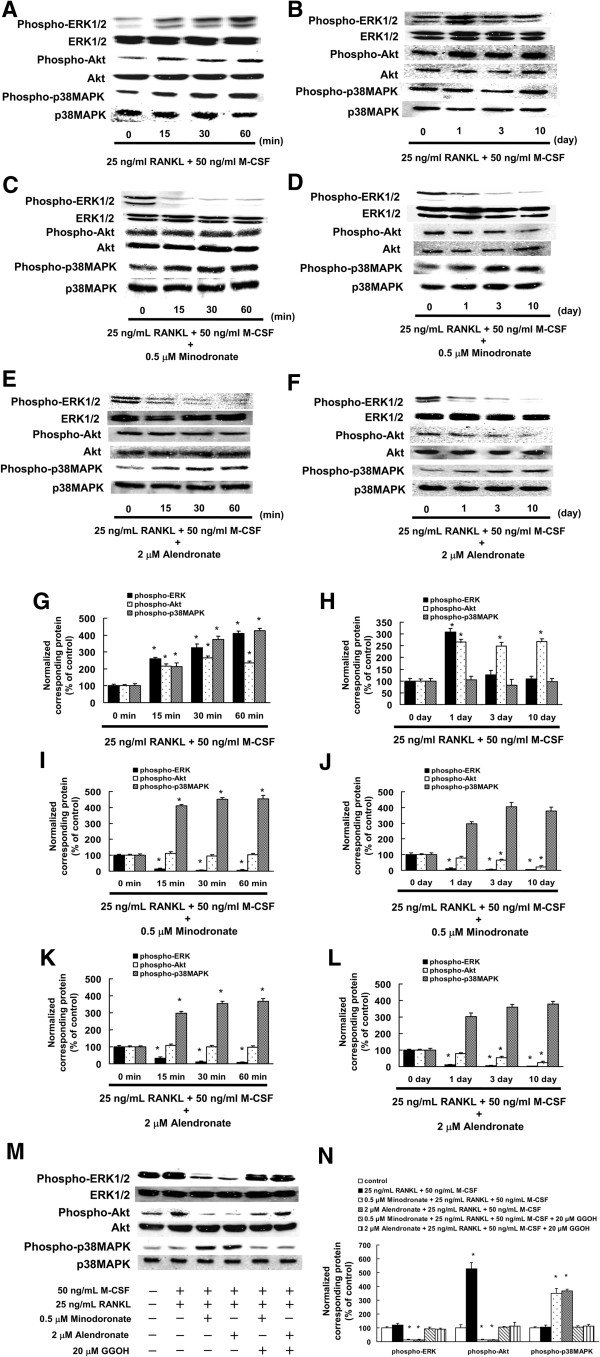
RANKL plus M-CSF induced activation of ERK1/2 and Akt in C7 cells, which could be inhibited by minodronate and alendronate. (A, B) C7 cells were cultured in the presence of 25 ng/mL RANKL plus 50 ng/mL M-CSF for 15, 30, and 60 min (A) or 1, 3, and 10 days (B). (C, D) C7 cells were treated with 0.5 μM minodronate for 24 h. Cells were cultured in the presence of 25 ng/mL RANKL plus 50 ng/mL M-CSF for 15, 30, and 60 min (C) or 1, 3, and 10 days (D). (E, F) C7 cells were treated with 2 μM alendronate for 24 h. Cells were cultured in the presence of 25 ng/mL RANKL plus 50 ng/mL M-CSF for 15, 30, and 60 min (E) or 1, 3, and 10 days (F). Whole cell lysates were generated and immunoblotted with an antibody against phosphorylated ERK1/2 (phospho-ERK1/2), phosphorylated Akt (phospho-Akt), phosphorylated p38MAPK (phospho-p38MAPK), ERK1/2, Akt, and p38MAPK. (G–L) Quantification of the amount of phospho-ERK1/2, phospho-Akt, or phospho-p38MAPK normalized to the amount of total ERK1/2, Akt, or p38MAPK, respectively. The results are representative of 5 independent experiments. *P < 0.01 compared to controls. (M) ERK1/2, Akt, and p38MAPK activation in C7 cells, to which minodronate and alendronate were administered with or without the addition of GGOH. Phospho-ERK1/2, phospho-Akt, phospho-p38MAPK, ERK1/2, Akt, and p38MAPK levels were determined by immunoblotting analysis of the whole cell lysate. (N) Quantification of the amount of phospho-ERK1/2, phospho-Akt, or phospho-p38MAPK normalized to the amount of total ERK1/2, Akt, or p38MAPK, respectively. The results are representative of 4 independent experiments. *P < 0.01 compared to controls.